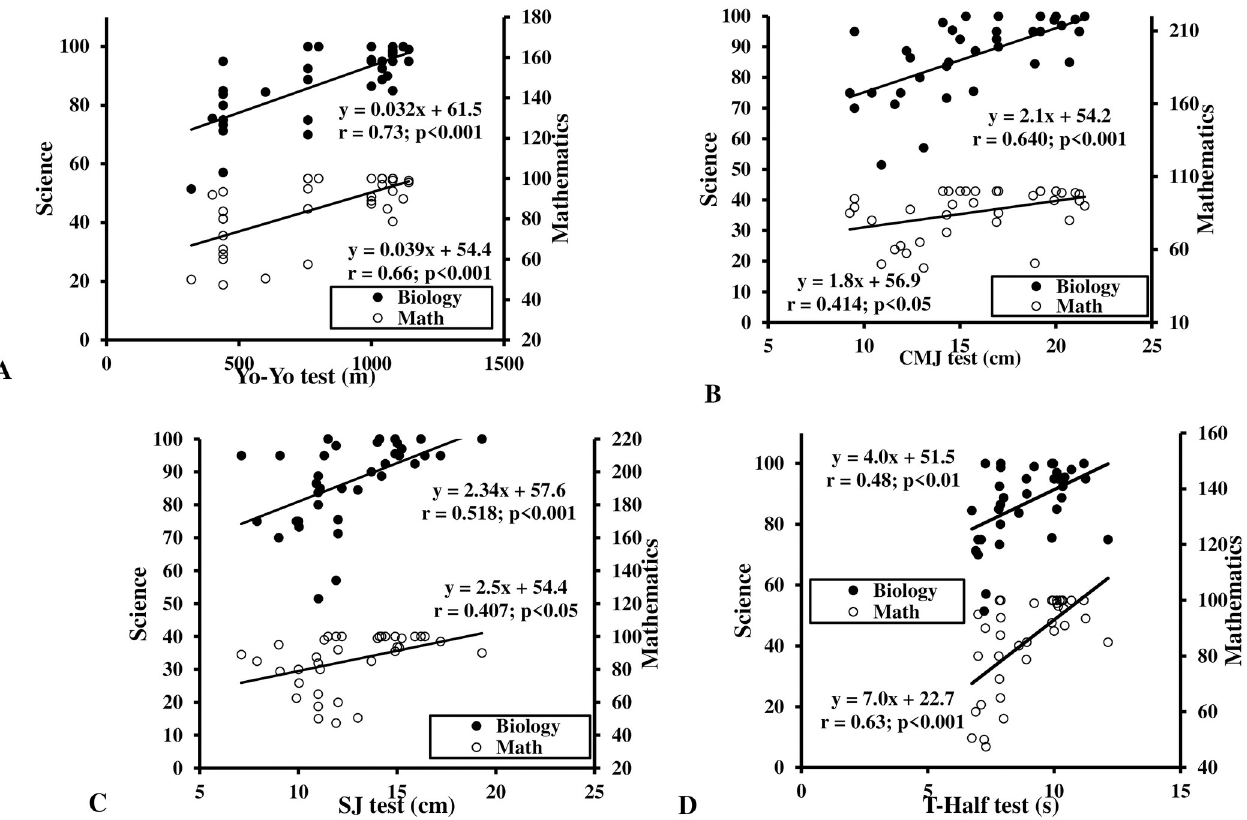
Fig 2. Relationship between academic scores (Science and mathematics with physical fitness variables performances: A: Aerobic score; B: Countermovement jump performance; C: Squat Jump performance; D: T-half test; SJ: Squat Jump; CMJ: Countermovement jump.